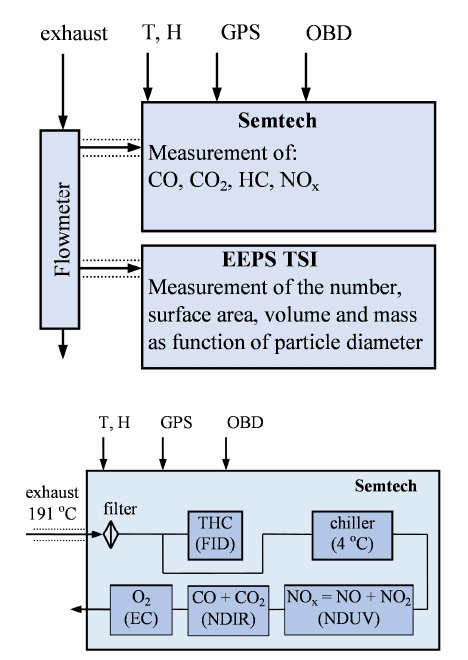
Fig. 1. The RDE test requirements [2–5]